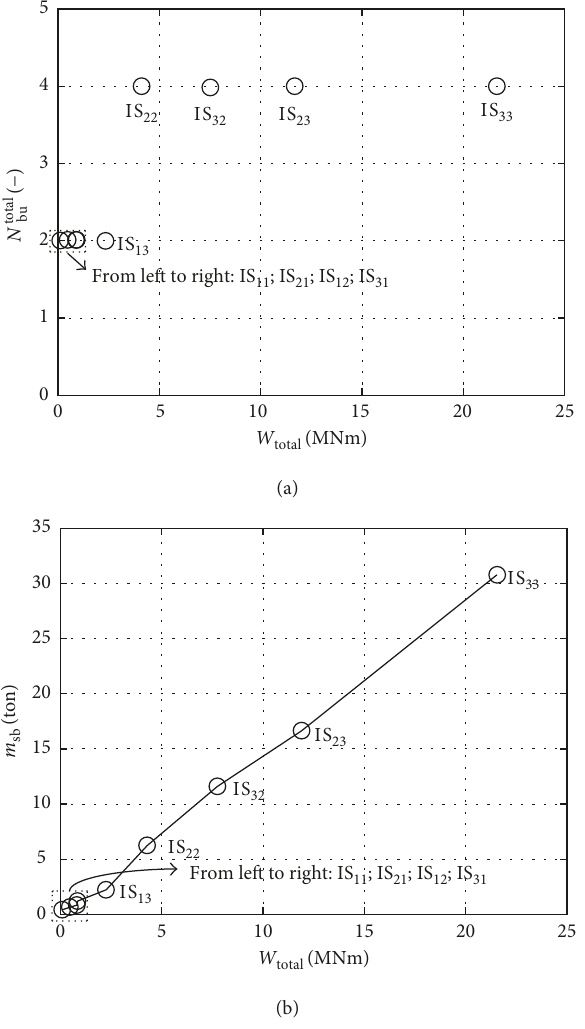
Figure 19: Maximum cap displacement D max impact force on the bridge pier F max (b) versus barge impact energy W total using the optimum device.